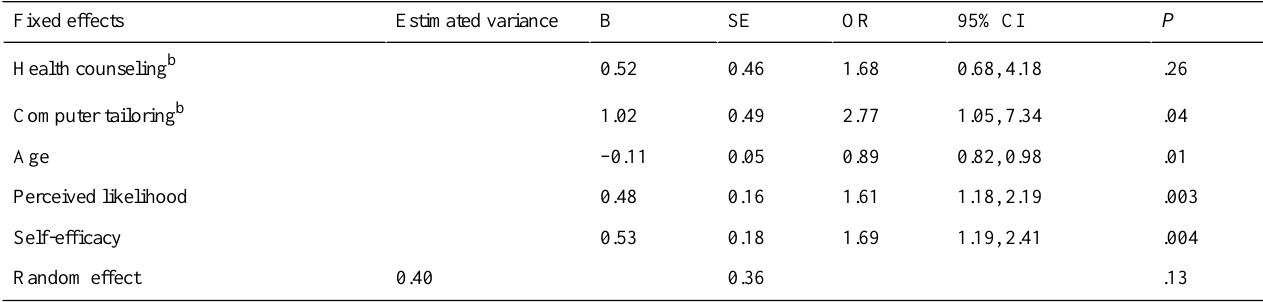
Table 2. Final model of the multilevel multiple logistic regression analysis concerning drinking behavior at T2 (N=241).